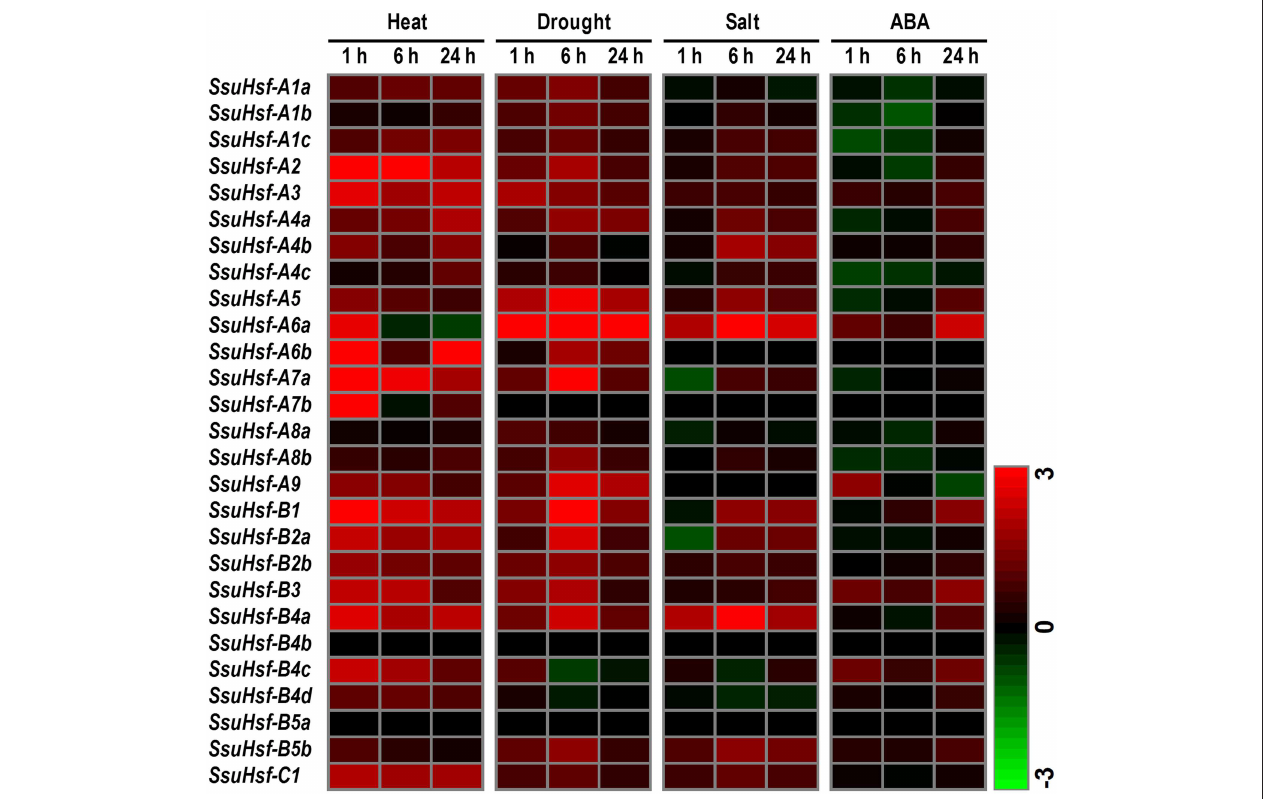
FIGURE 8 | Expression analyses of SsuHsfs under abiotic stresses. Heat map representation for the expression patterns of 27 SsuHsf genes after treated for 1, 6, or 24h under heat (37 ◦ C), drought (20% PEG), salt (150mM NaCl), or 100 µ M ABA. The expression levels of genes were determined using RT-PCR. The different colors correspond to log2 transformed values compared with control (0h). Green indicates down-regulation and red represents up-regulation. The data were generated by averaging the fold change from each of the three biological replicate experiments. Details of the expression data are listed in Table S3